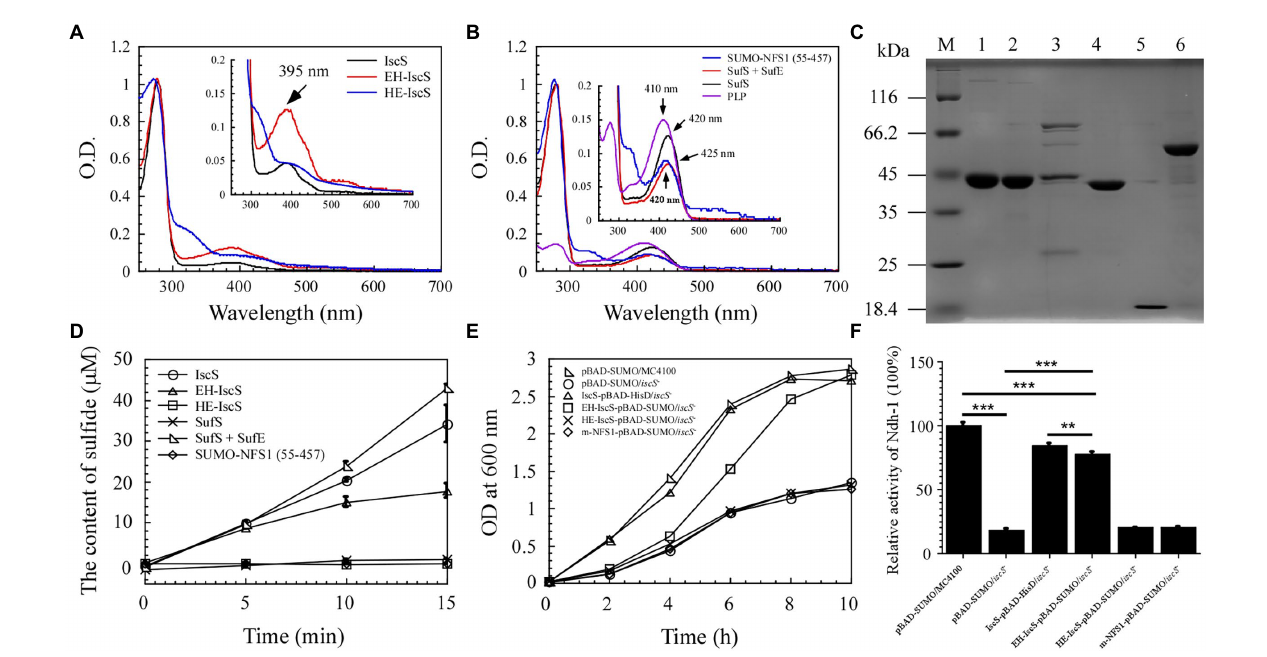
FIGURE 3 The chimeric CD EH-IscS exhibited desulphurising enzymatic activity, and it restored cell growth of the △ iscS single mutant. (A) UV-visible spectra of purified IscS (25 μ M), EH-IscS (29 μ M), and HE-IscS (24 μ M); (B) UV-visible absorption spectra of purified SUMO-NFS1 (55–457; 27 μ M), SufS (21 μ M), SufE (48 μ M), and PLP (20 μ M). The absorption peak at 395 nm (Figure 3A) or 420 nm (Figure 3B) indicates PLP contained in recombinant CDs. Inserts in Figures 3A,B are megascopic absorption spectra of PLP in recombinant CDs. All proteins were dissolved in buffer A containing 500 mM of NaCl and 20